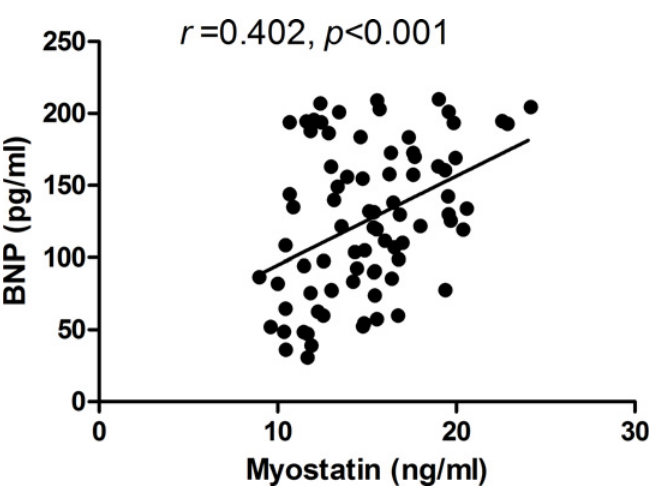
Fig 2. Relationship between plasma myostatin and B-type natriuretic peptide (BNP) levels: a significant correlation was observed between them in patients with COPD.